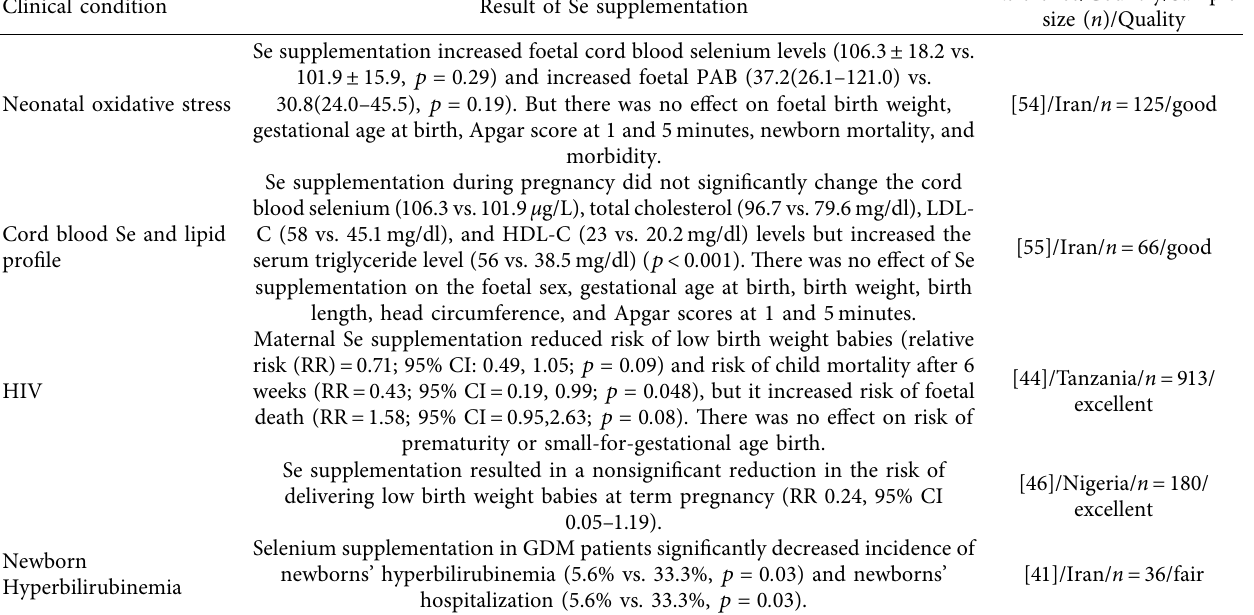
Table 2: Reported neonatal outcomes on Se